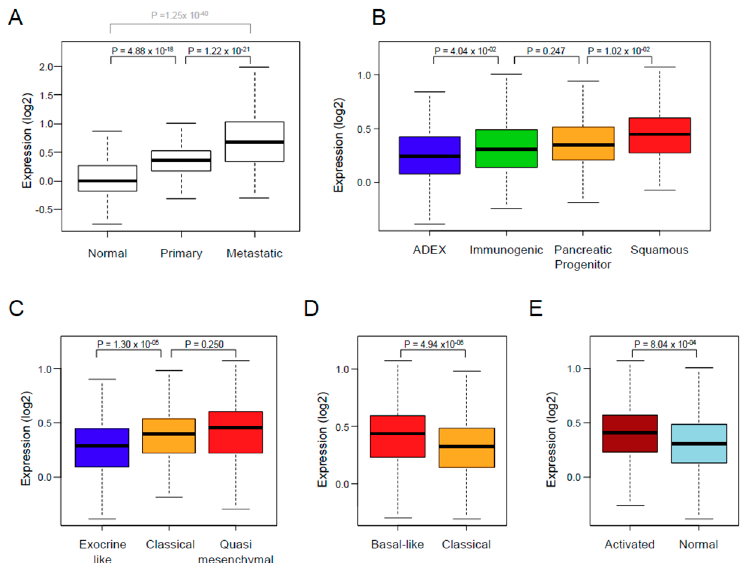
Figure 1. XPO1 expression in PAC. ( A ) Box plots showing XPO1 mRNA expression level (log 2 ) in 95 normal pancreatic samples, 573 primary PAC, and 73 metastatic samples. For each box plot, median and ranges are indicated. The p -values are for Student t -test. ( B – E ) Similar to A , but in primary PAC only and according to the molecular subtypes that are defined by Bailey ( B ), Collisson ( C ), Moffitt ( D : tumor subtypes), and Moffitt ( E : stroma subtypes).